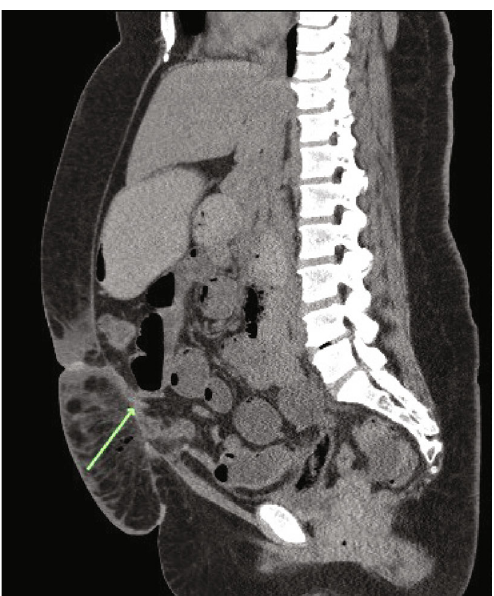
Figure 2: CT abdomen and pelvis showing a markedly distended stomach and proximal jejunum with a transition zone within the rectus abdominis musculature.